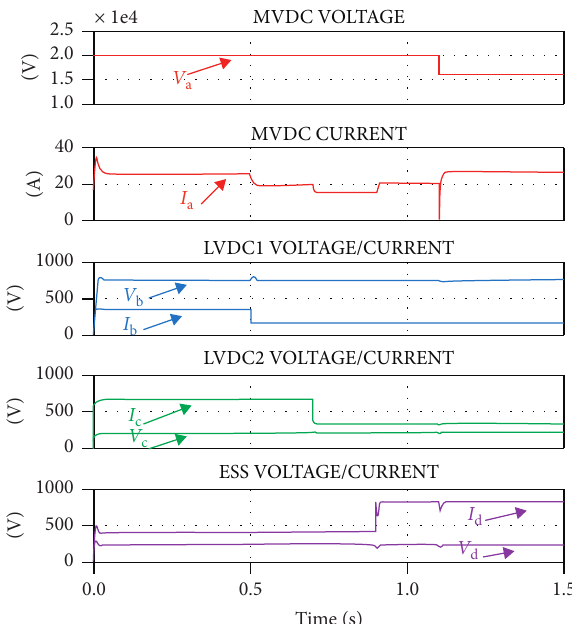
Figure 15: Mode 1 disturbance test